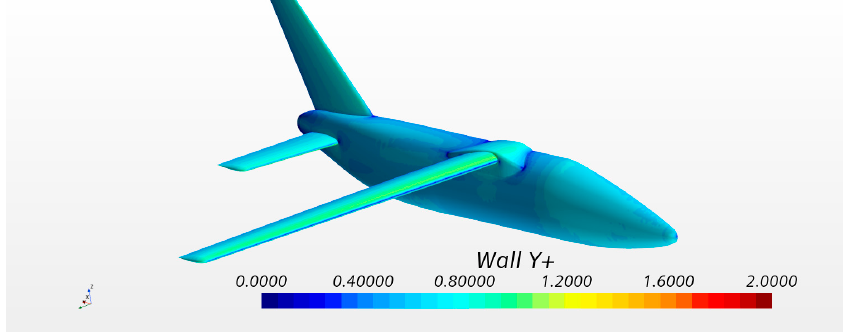
Figure 4. Wall Y+ map, Star-CCM+, cruise condition, M = 0.32, Re = 9.2 Mil.